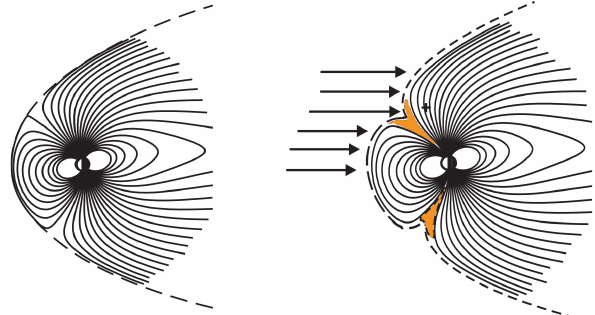
Fig. 20. Polar cusps in an idealized vacuum model with only a pair of null B points (left), and in the real magnetosphere, with deep intrusions of the magnetosheath plasma (right). 1165 Thesecondimportantphenomenonassociatedwiththepolarcuspsisahighcorrelationofthe B y - component inside the cusp funnels with IMF B y . As found in a statistical study of that effect based on Polar and Cluster data (Tsyganenko, 2009), the linear regression coefficient relating B cusp y with B IMF y dramatically (five-fold!) and monotonically rises with decreasing geocentric distance from 2.4 at 6 ≤ R ≤ 7 to 12.6 at 2 ≤ R ≤ 3 . Such a stunning steepness and regularity perfectly agrees 1170 with the interpretation of IMF ‘penetration’ into the cusps in terms of the Region-0 FACs, with their orientation and magnitude being controlled by the IMF B y (McDiarmid et al., 1979; Erlandson et al., 1988; see Tsyganenko, 2009, for more references.) Boththeaboveeffectsarenotyetincludedinthemodels. Whilethecuspdepressionisarelatively local effect, and, as such, does not dramatically affect the global field line mapping, the transverse 1175 zonal field due to the Region 0 currents may result in significant azimuthal shifts of the field line 44